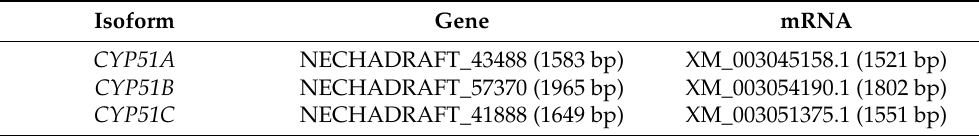
Table 2. Genes and mRNA accession numbers of Fusarium vanettenii mpVI 77-13-4 used in this study. Isoform